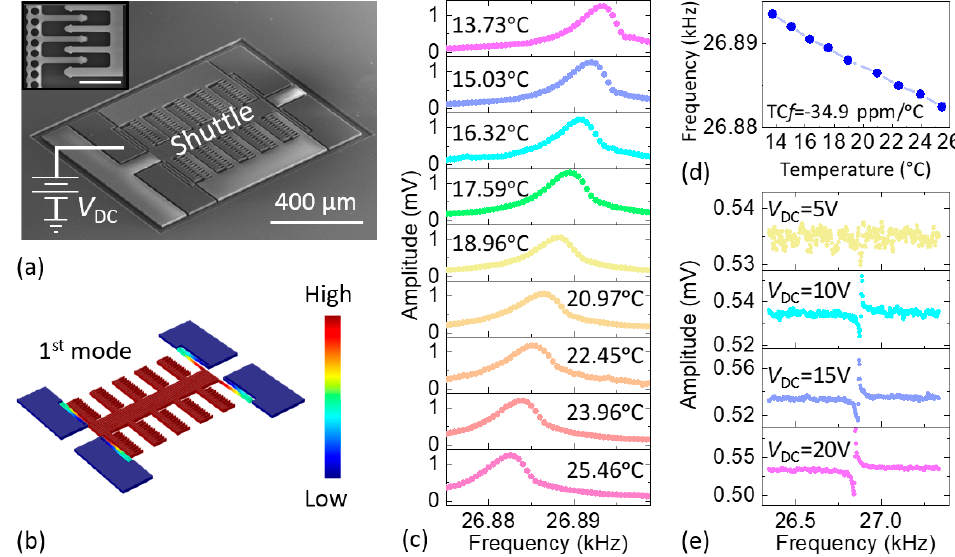
Figure 2. Single-crystal Si-on-insulator (SOI) comb-drive MEMS resonator characteristics. ( a ) Scanning electron microscopy (SEM) image. The inset shows a partial zoom-in view of the comb drive and fingers. Scale bar: 20 µ m; ( b ) Simulated vibration pattern and mode shape for the first in-plane resonance mode; ( c ) Optically measured transmission data and frequency response around the first resonance as temperature increases; ( d ) Open-loop resonance frequency dependence on temperature for the extraction of TC f from the data in ( c ); ( e ) Electrically measured transmission and frequency response when various values of the DC polarization voltage are applied to the shuttle. The responses in ( c , e ) have not been converted to dimensionless transfer functions since the measurement path includes both electrical and optical components, which makes it difficult to derive absolute calibration factors.